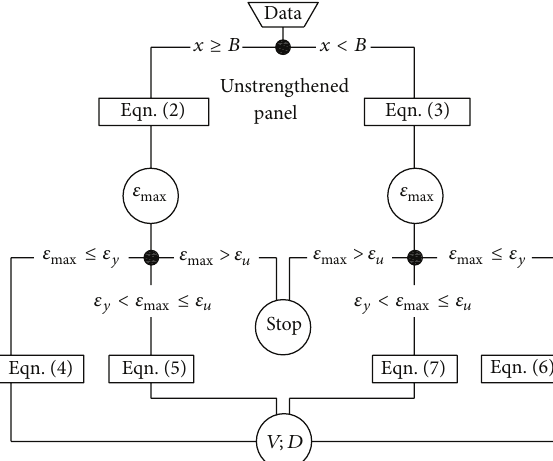
Figure 3: Flowchart of the procedure for unstrengthened panels.